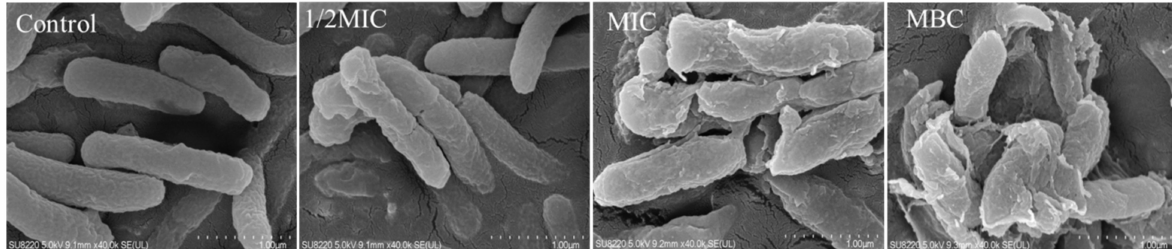
Figure 3. FESEM images ( × 40,000) of the cell membrane of P. syringae